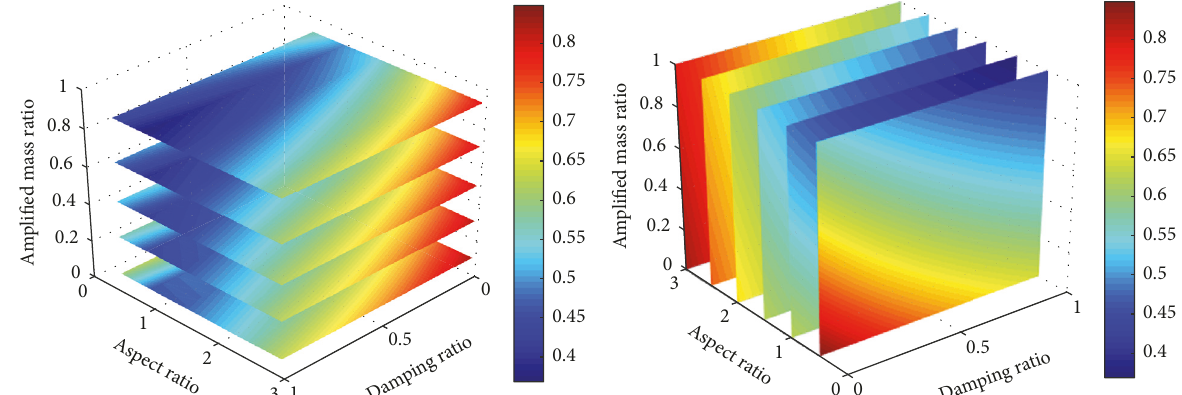
(b) Slices at the constant aspect ratio values ( 𝑠 = 0.5 , 1.0, 1.5, 2.0, 2.5, 3.0)